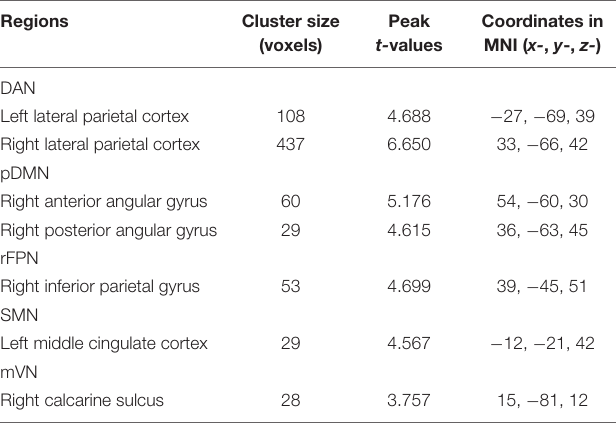
TABLE 2 | Brain regions showing increased intranetwork functional connectivity in female MDD patients relative to female HC. Regions Cluster size